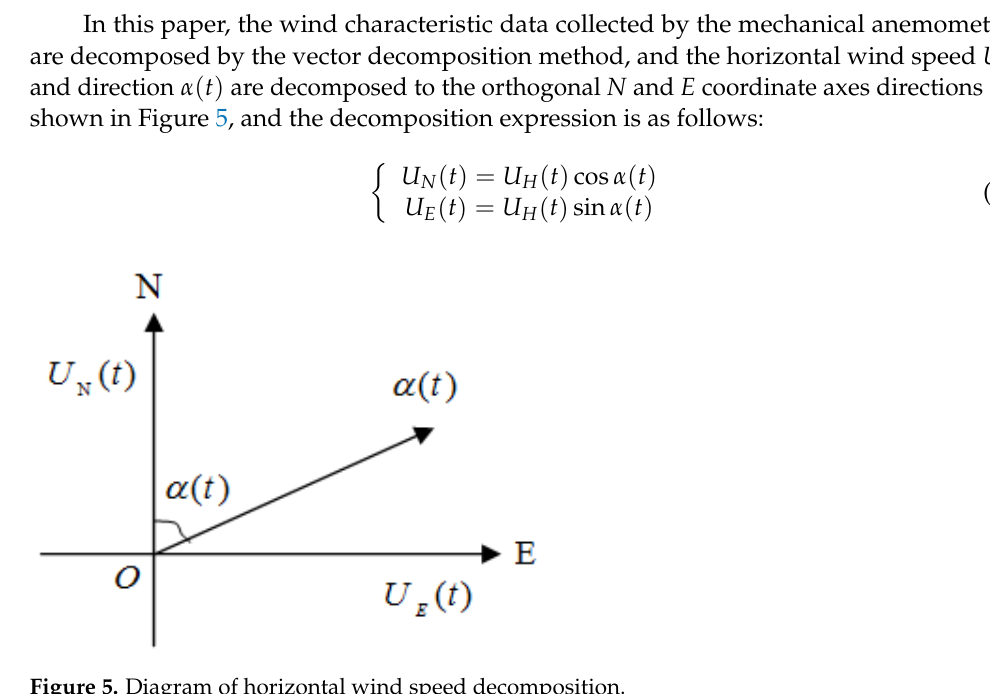
Figure 5. Diagram of horizontal wind speed